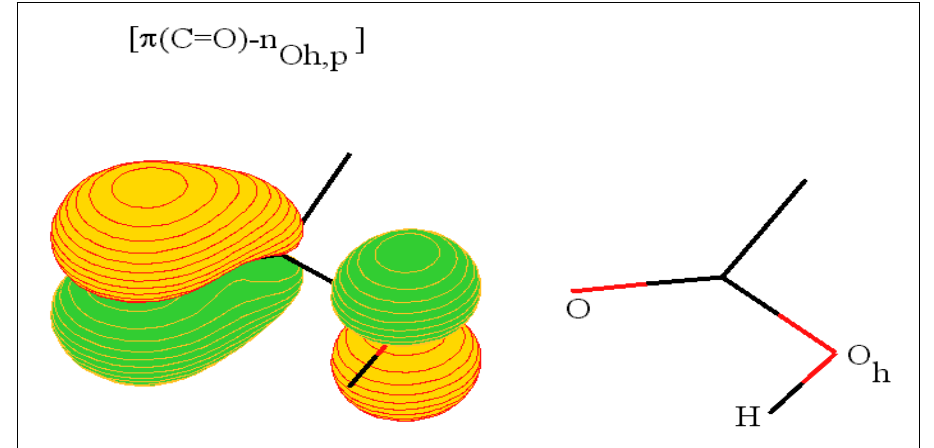
Figure 3 : Highest occupied π -type MO in the COOH